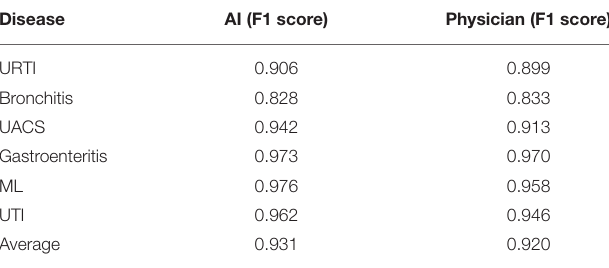
TABLE 4 | Diagnostic performance of the AI model and the physician for the dataset four ( n = 536).